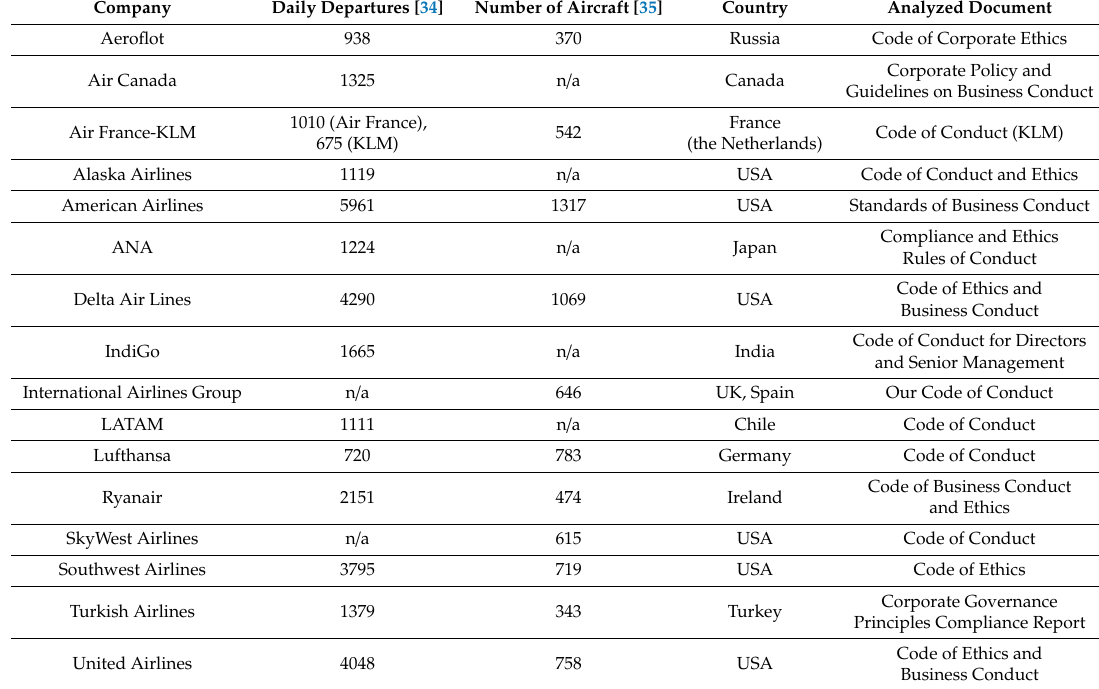
Table 1. The airline companies considered in the present